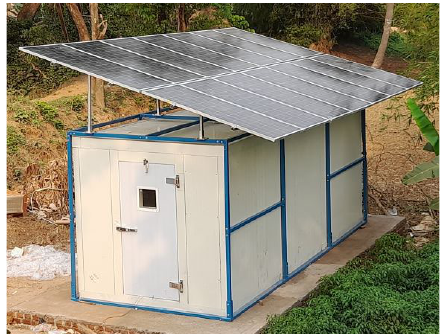
Figure 7. Solar cold room (source: PLUSS Advanced Technologies Ltd.).